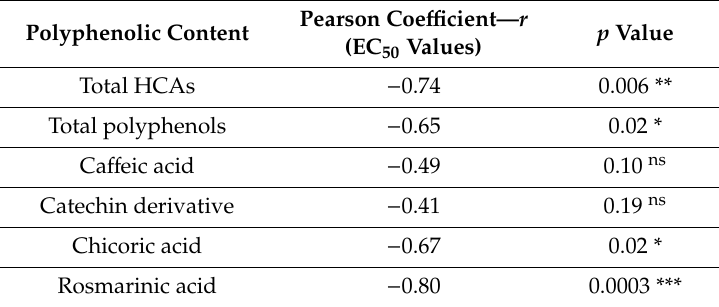
Table 2. Pearson correlation analysis between the antioxidant capacity (EC 50 values) and the polyphenolic content of leaf extracts.